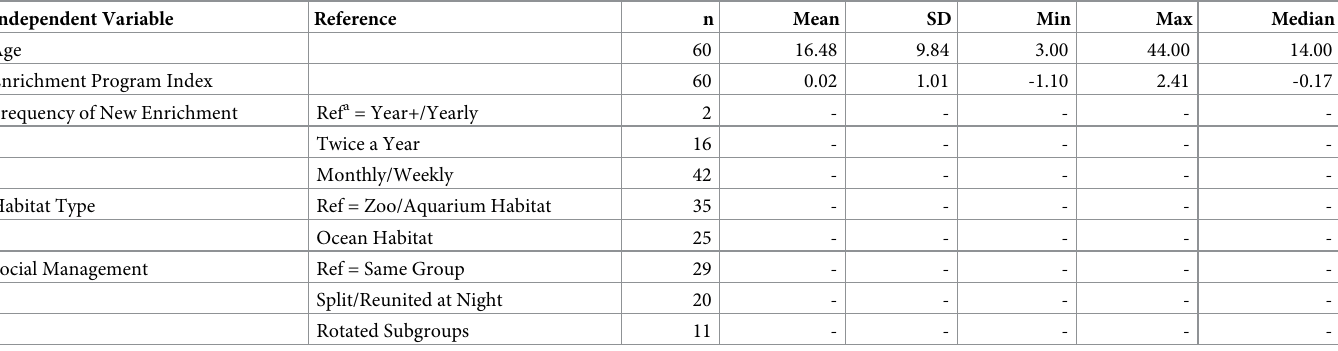
Table 5. Descriptive statistics for the independent variables included in the multivariate modeling process.